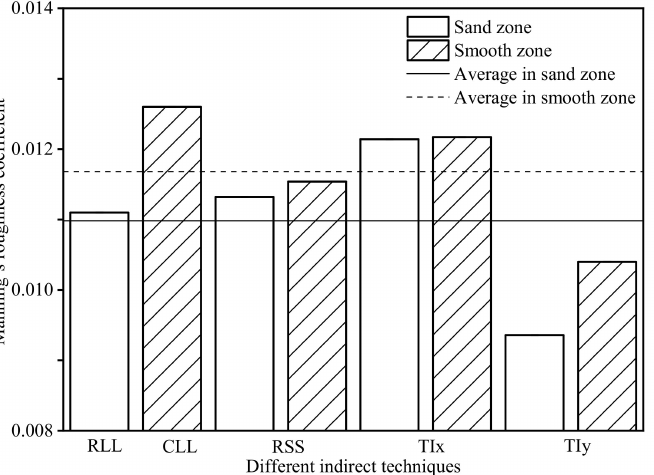
Figure 12. The Manning roughness coefficient estimated by different indirect methods in the sand zone and smooth zone.